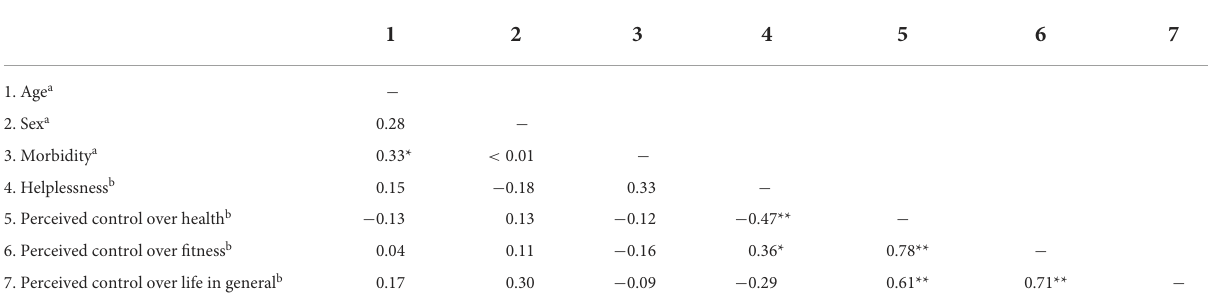
TABLE 2 Zero-order correlations of main study variables.